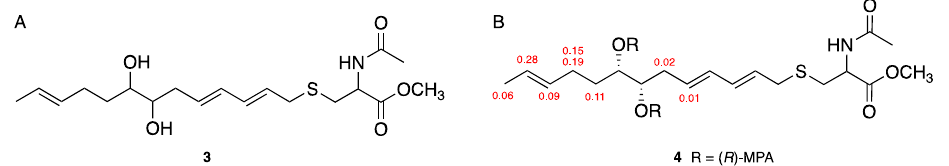
Figure 3. ( A ) The structure of methylated 1 , ( B ) ∆ δ values ( ∆ δ in ppm) = ∆ δ T1T2 ) obtained for (R)-MPA diester ( 4 ). Figure 4. Determination of absolute configuration of the N -acetylcysteine moiety derived from 1 by